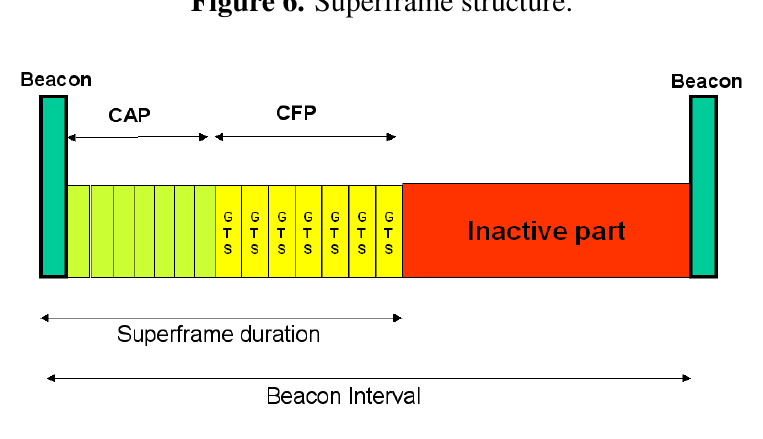
Figure 6. Superframe